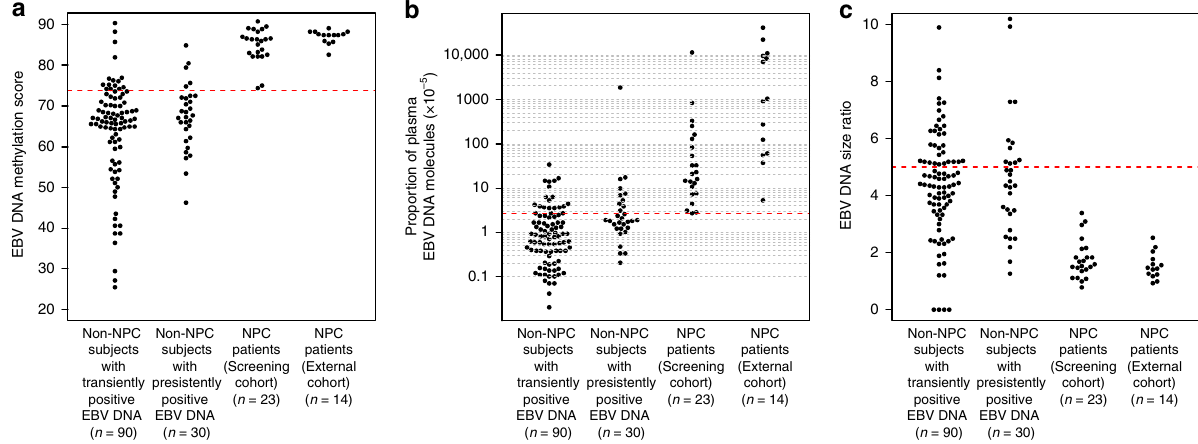
Fig. 4 Methylation-, count- and size-based analyses of plasma EBV DNA in the validation sample set. The cutoffs in the corresponding analyses de fi ned in the exploratory dataset are shown. a The EBV DNA methylation scores of the NPC patients (from both the screening and external cohorts) and non-NPC subjects with transiently positive and persistently positive results are shown. The same cutoff value of 73.7 de fi ned in the exploratory dataset is denoted by the red dotted line. b The proportion of EBV DNA reads among the total number of sequenced plasma DNA reads (both human and viral) of the NPC patients (from both the screening and external cohorts) and non-NPC subjects with transiently positive and persistently positive results are shown. The same cutoff value of 2.7 × 10 − 5 de fi ned in the exploratory dataset is denoted by the red dotted line. c The EBV DNA size ratios of the NPC patients (from both the screening and external cohorts) and non-NPC subjects with transiently positive and persistently positive results are shown. The same cutoff value of 5.0 de fi ned in the exploratory dataset is denoted by the red dotted line. Source data are provided as a Source Data fi